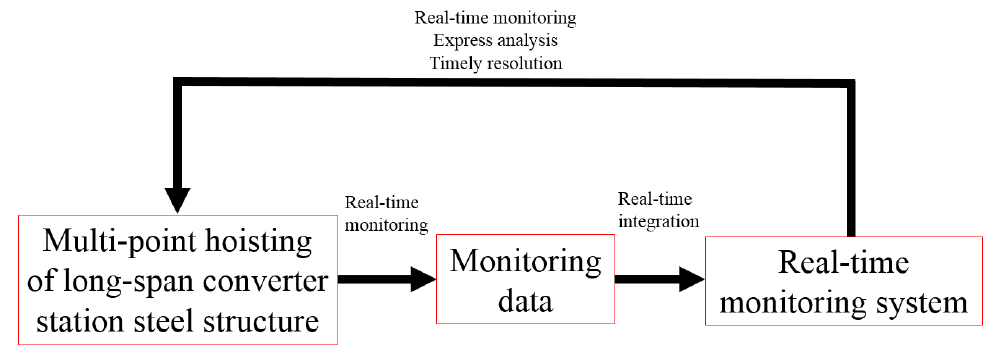
Figure 3. Monitoring principle.